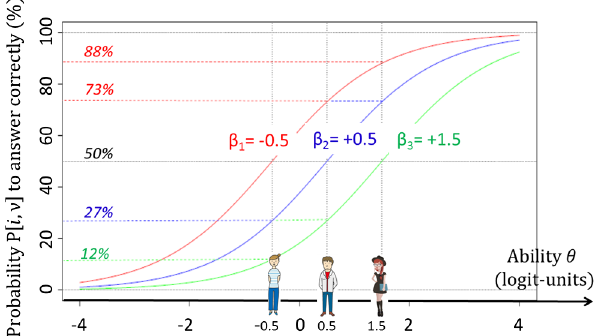
FIG. 1. Probabilistic model of the interaction person